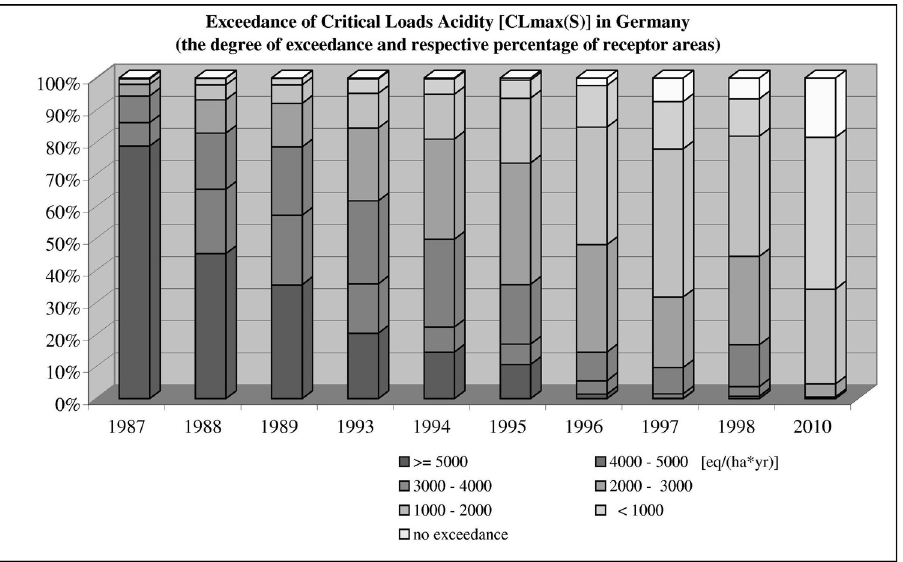
FIGURE 8 . Exceedance of critical loads for acidity determined for 1987–1998 and estimated for 2010, after the full implementation of the Gothenburg Protocol.